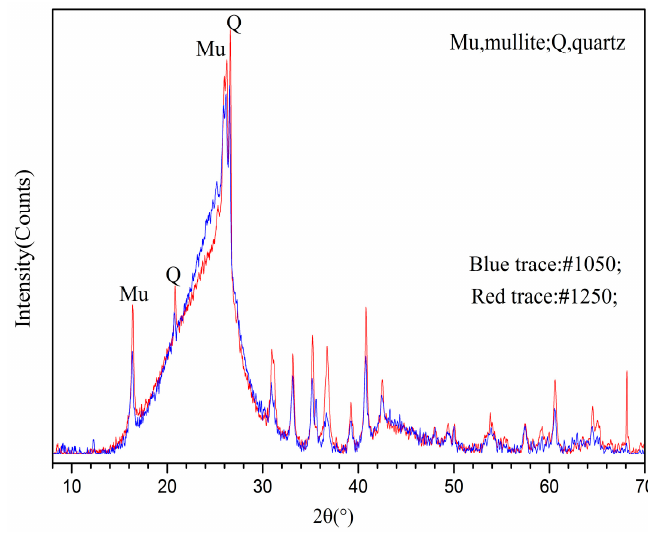
Figure 7. XRD patterns for boiling acid separation residues of 1050 and 1250 °C DTF ash of WX light coal.